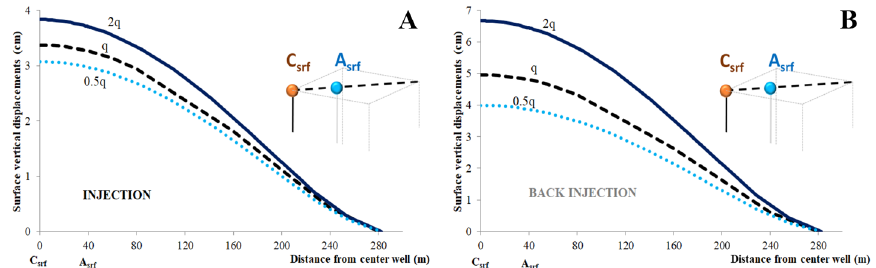
Fig. 23 Surface vertical displacements for different injection flow rates (0.5q, q and 2q) in the injection ( A ) and in the back injection ( B